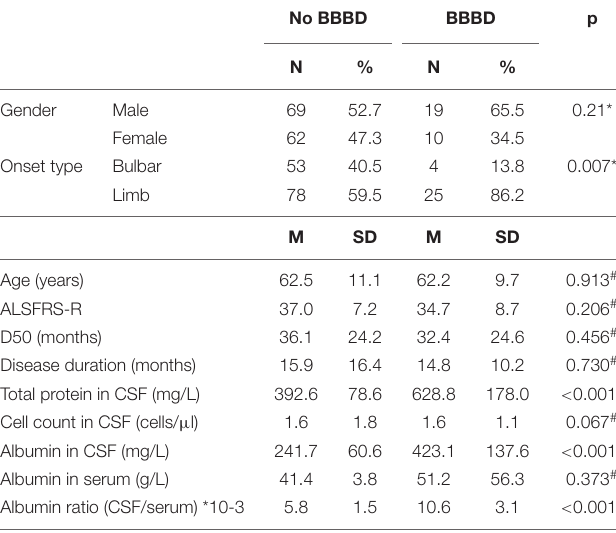
TABLE 2 | Characteristics of ALS patients with and without blood–brain barrier damage (BBBD).